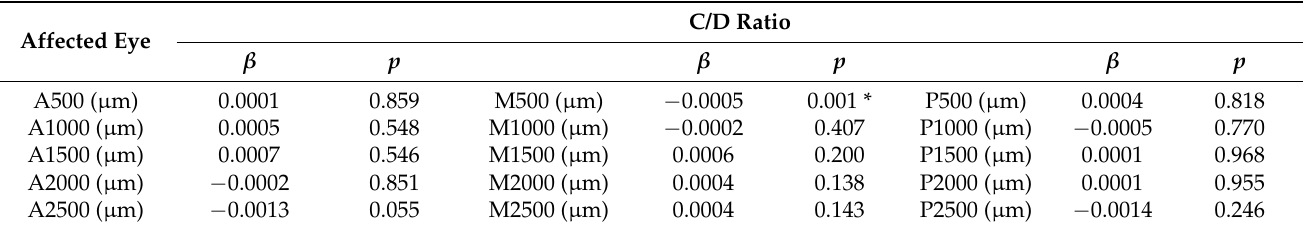
Table 3. Univariate linear regression of associations of iris thickness and C/D ratio in PSS-affected eyes.